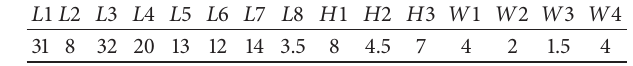
Table 1: Optimized values of the antenna geometrical parameters (in